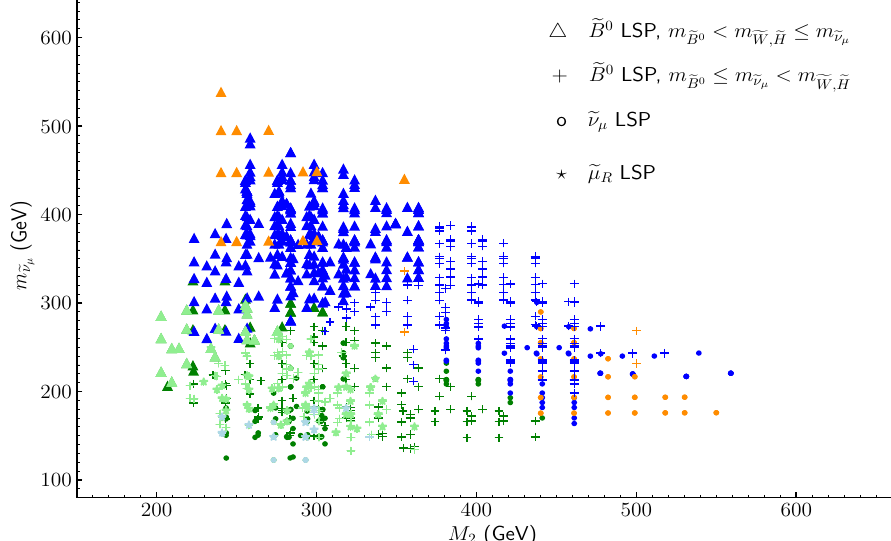
Fig. 8 m (cid:2) ν μ versus M 2 for points in the parameter space of the μν SSM in agreement with the experimental